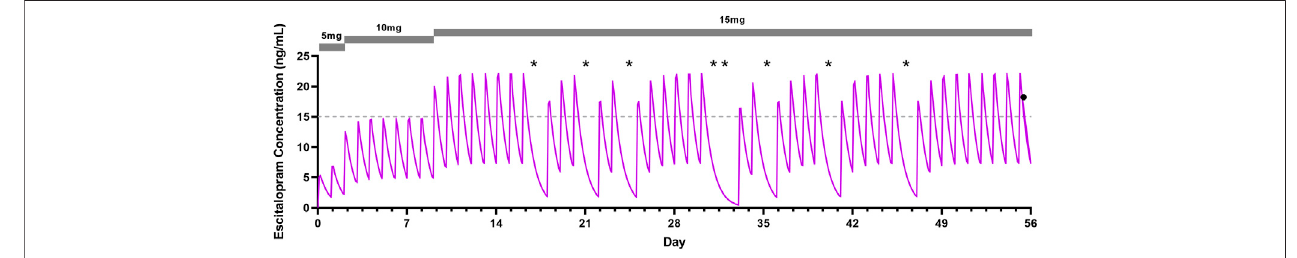
FIGURE 2 | Modeled escitalopram concentration-time pro fi le in a 16-year-old adolescent female CYP2C19 rapid metabolizer with generalized anxiety disorder. Escitalopram dosage is shown in the gray bar (top) and the impact of partial adherence can be seen in the signi fi cant decreases in concentration that occurred intermittently beginning in the third week of treatment. The asterisks represent missed doses. The gray dotted-line represents the lower therapeutic threshold for escitalopram (Hiemke et al., 2018). Asterisks represent missed doses, and the black dot re fl ects the escitalopram determination at the completion of the study.